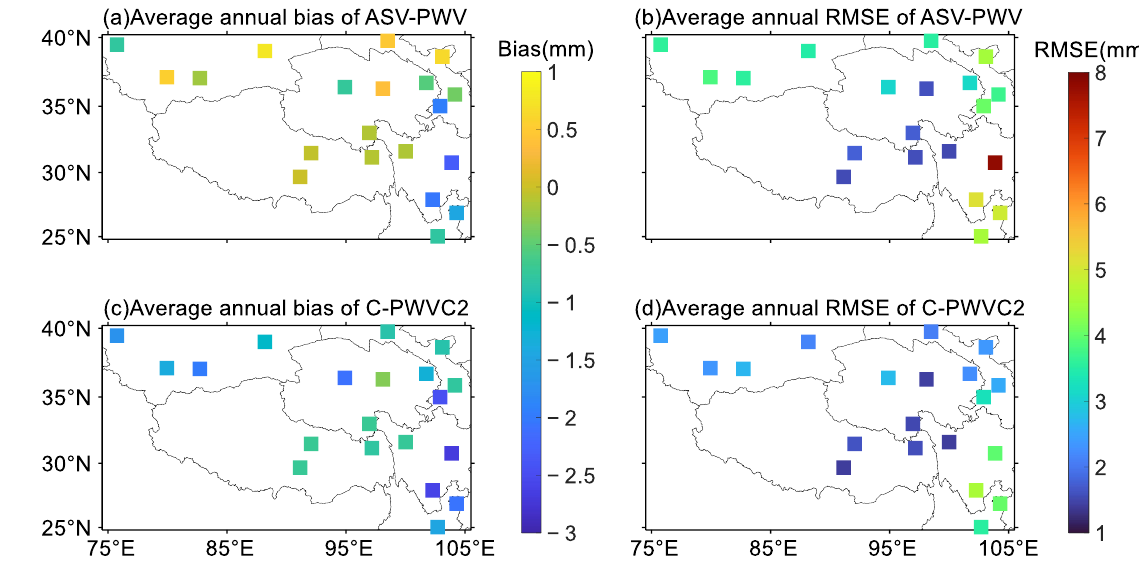
Table 1. Average annual bias and RMSE of the ASV-PWV and C-PWVC2 in 2020.